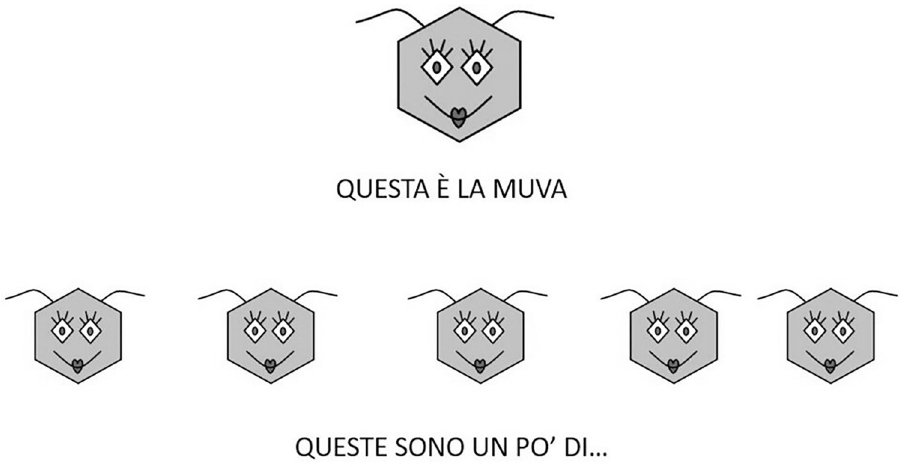
Fig 1. Representation of an experimental item administered in Task 1 addressing the pluralization of invented